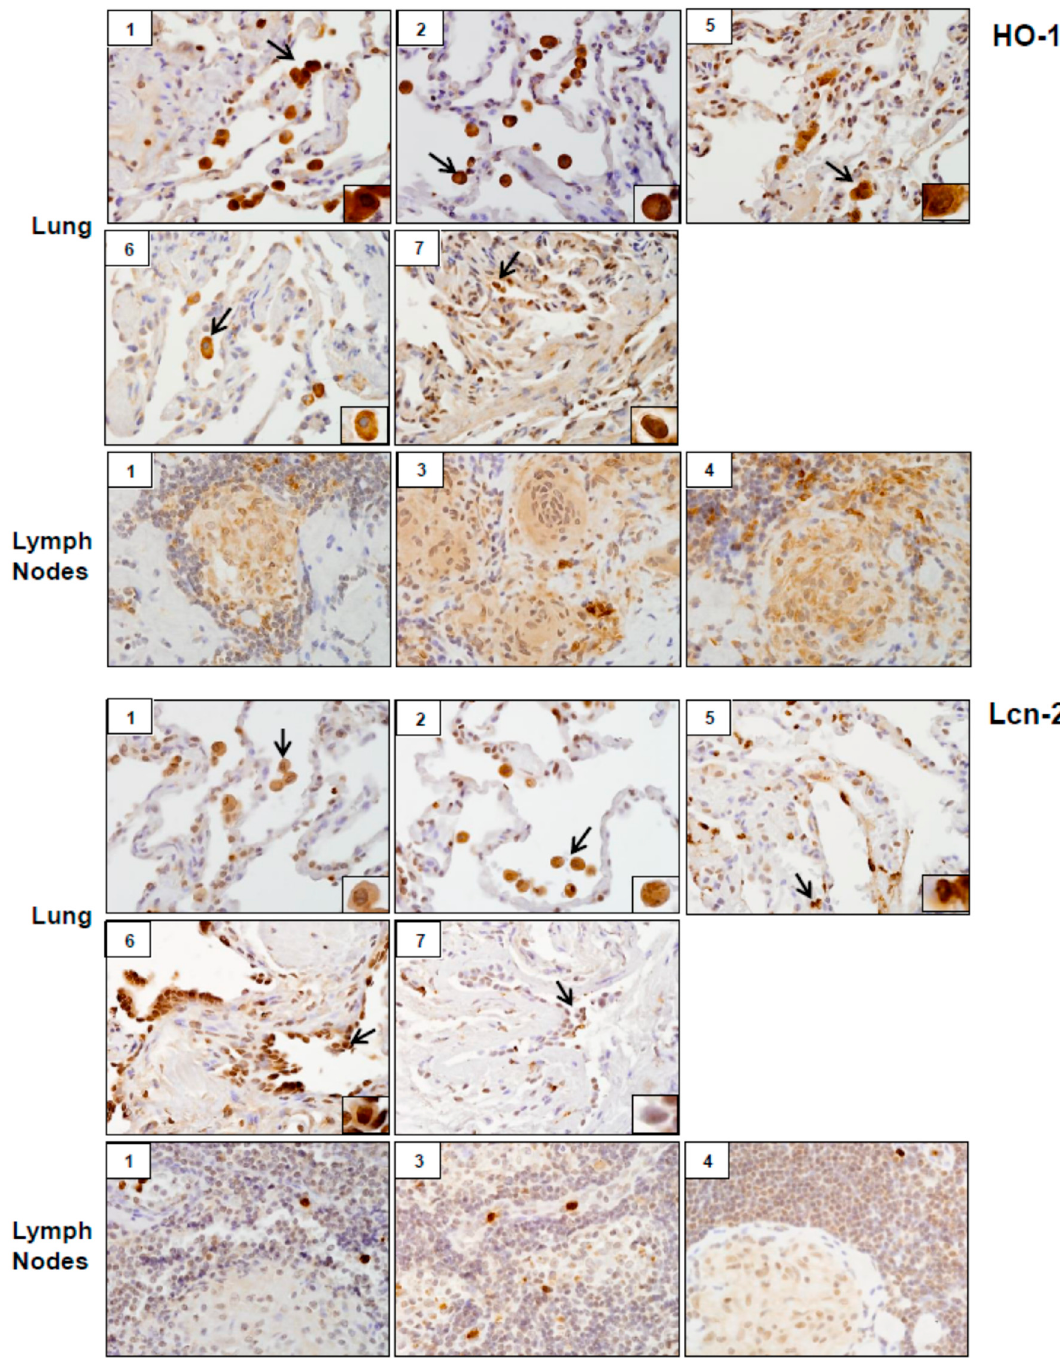
Figure 4. Hemeoxygenase (HO)-1 and Lipocalin (Lcn)-2 expression in lung and/or lymph nodes collected from WTC rescue and recovery workers. Sections were immunostained with antibody to HO-1 or Lcn-2. Binding was visualized using a DAB peroxidase substrate kit. One representative section from each patient is shown. Inset, patient number. Magnification, 60×; arrows, alveolar macrophages.